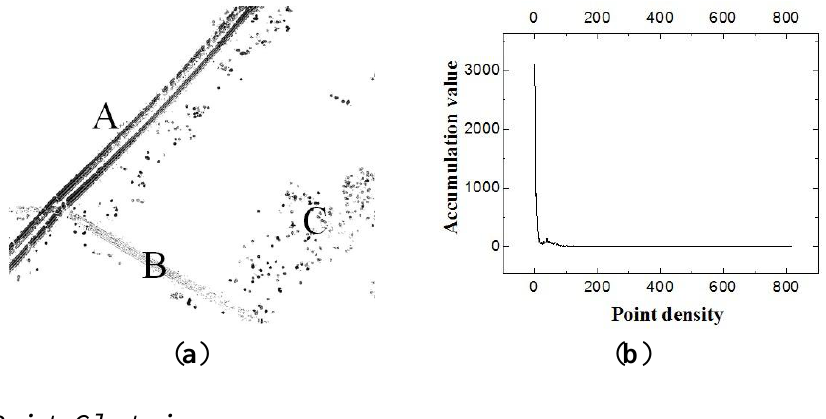
Figure 4. Neighboring voxel filtering. ( a ) A single voxel filtering example. ( b ) Point density accumulation.